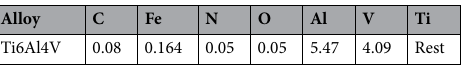
Table 1. Machined Alloy composition (mass